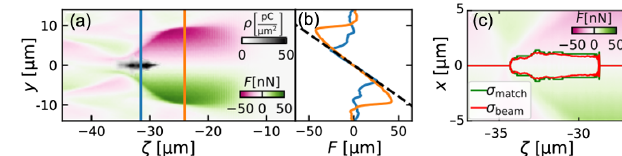
FIG. 5. Beam loading in PIC simulation: (a) illustrates the focusing field map F ¼ e ð E − cB Þ for an injected charge of 100 p C at z ¼ 1 . 7 mm. The density of injected electrons and the focusing force are indicated by the gray and color scale at the bottom right, respectively, (b) presents two line outs of the focusing force in front of the bunch (orange) and at the bunch (blue) emphasizing its linearity. The black dashed line in (b) indicates the theoretically predicted value − E 0 = 2 k p r [61], ð ζ Þ (red line) and the matched and (c) shows the beam size σ beam ð ζ Þ (green line) after injection ( z ¼ 1 . 1 beam size σ match